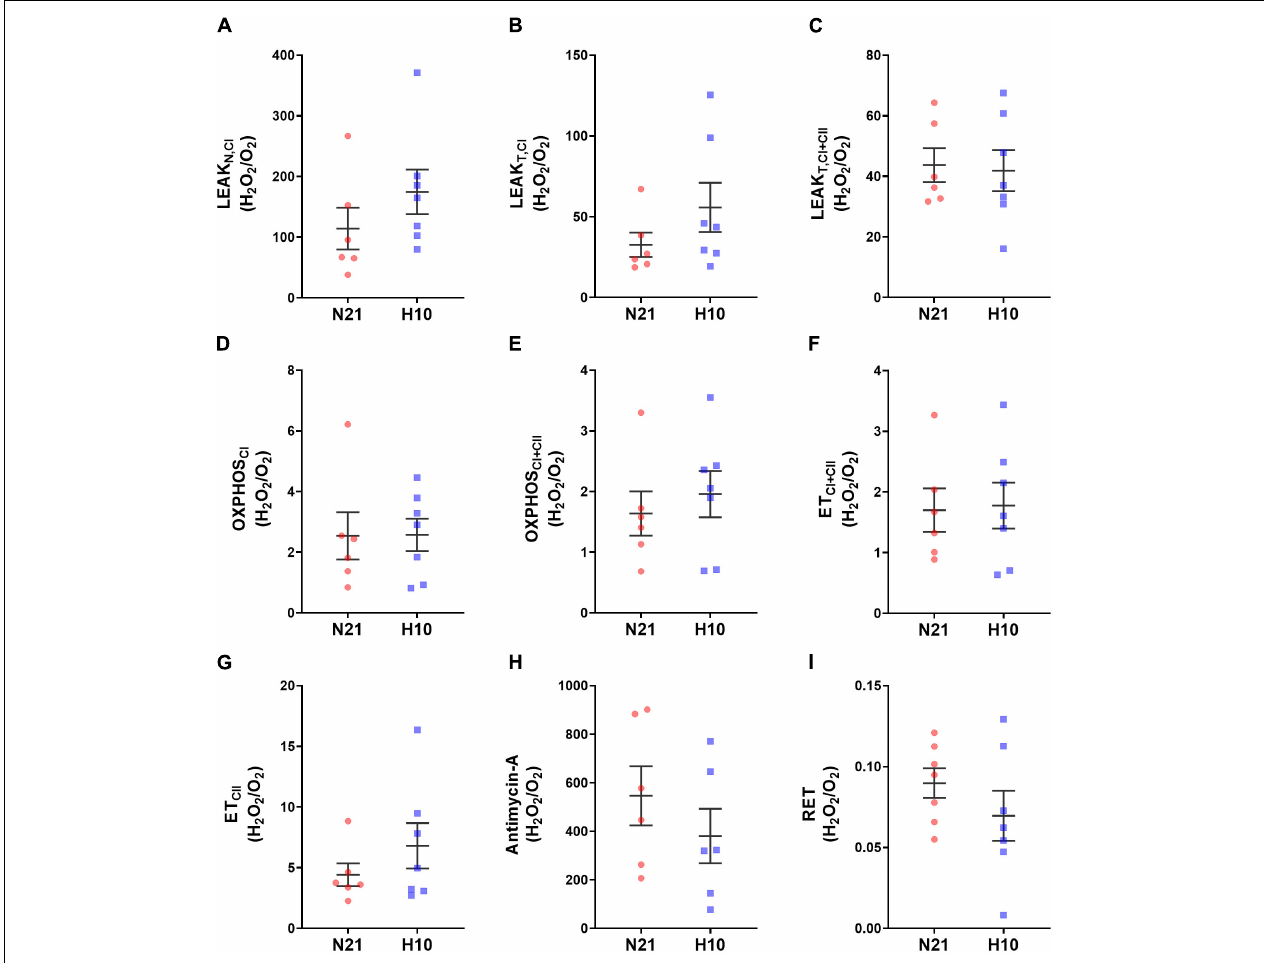
FIGURE 4 | Effect of developmental hypoxia on mitochondrial H 2 O 2 production, normlalised to respiration rate (H 2 0 2 /O 2 ). Mitochondrial H 2 O 2 production and respiration rate were measured in juvenile snapping turtles from normoxic (N21, red squares, n = 6) and hypoxic H10, (blue circles, n = 7) incubation. Each panel represents a respiratory state. (A) Leak respiration with substrates for complex I, in the absence of adenylates (Leak N , CI ). (B) Leak respiration with substrates for complex I, in the presence of adenylates (Leak T , CI ). (C) Leak respiration with substrates for complexes I and II, in the presence of adenylates (Leak T , CI + CII ). (D) Oxidative phosphorylation, with substrates for complex I (OXPHOS CI ). (E) Oxidative phosphorylation, with substrates for complexes I and II (OXPHOS CI + CII ). (F) Electron-transfer capacity, with substrates for complexes I and II (ET CI + CII ). (G) Electron-transfer capacity, with substrates for complex II (ET CII ). (H) Electron-transfer capacity, in the presence of antimycin-A. (I) Electron-transfer capacity during reverse electron transport (RET), in the presence of succinate. Statistical significance was assessed with individual generalized linear models, followed by Sidak post hoc tests, to assess the effect of developmental O 2 (N21 vs. H10). Values were considered significant when P ≤ 0.05. There were no statistical differences found between the experimental